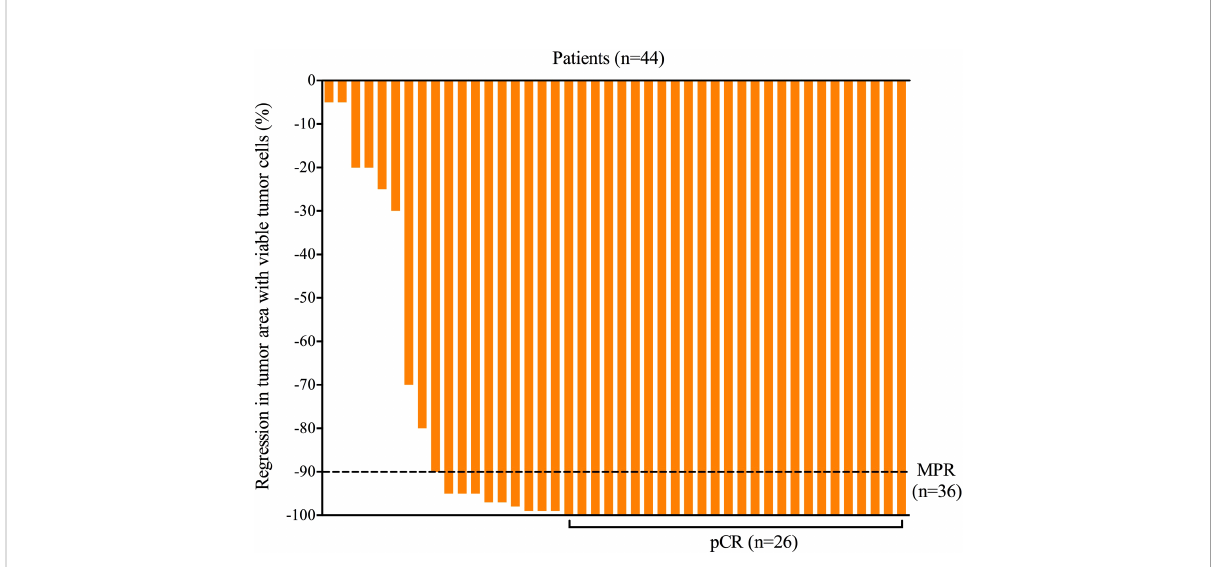
FIGURE 2 Regression in tumor area with viable tumor cells in surgical specimen of all patients after neoadjuvant chemoimmunotherapy. MPR, major pathological response; pCR, pathological complete